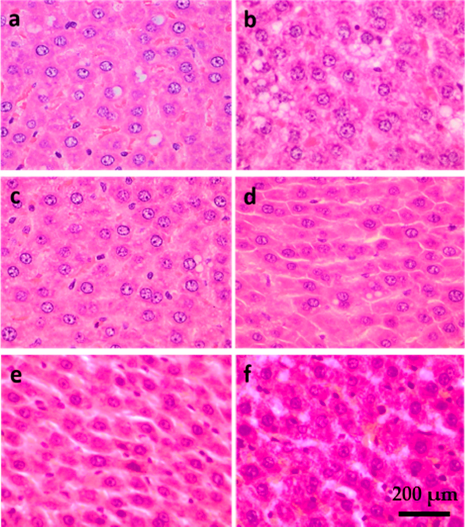
(high-fat diet, receiving lovastatin 2 mg / kg / day), ( d ) HFD-DR7 (high-fat diet, receiving L. plantarum DR7 (10 10 CFU / day), ( e ) HFD-DR9 (high-fat diet, receiving L. fermentum DR9 (10 10 CFU / day), ( f ) HFD-8513d (high-fat diet, receiving L. reuteri 8513d (10 10 CFU /